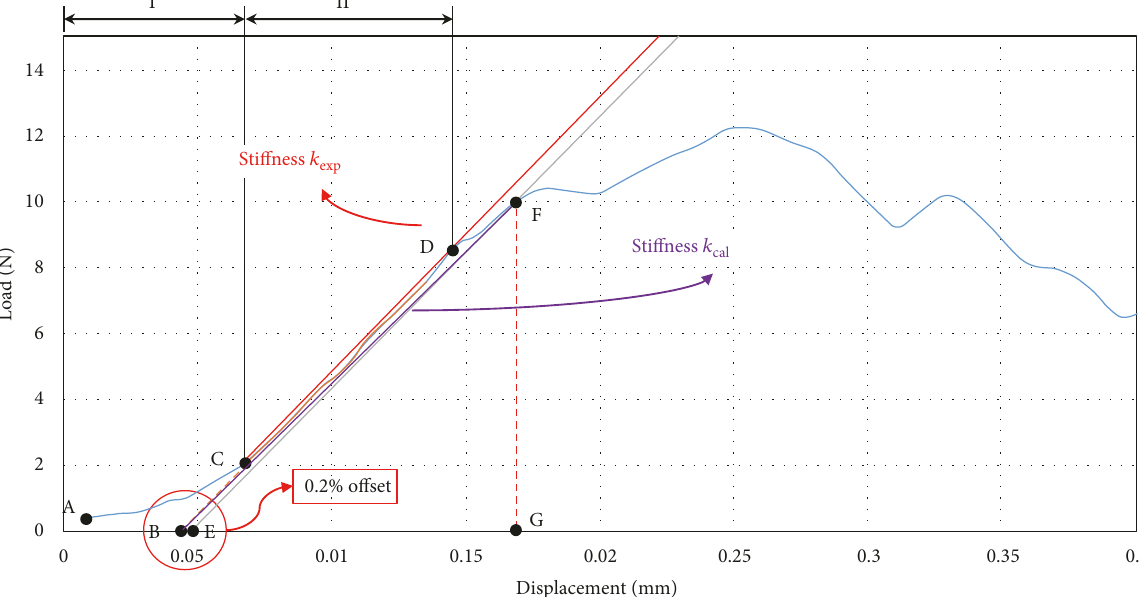
Figure 4: Load-displacement curve for the femoral head compression test of the CON group. Two characteristic curve regions are marked for load-displacement curve: (I) increasing contact region of the upper jig with the femoral head and (II) nearly linear